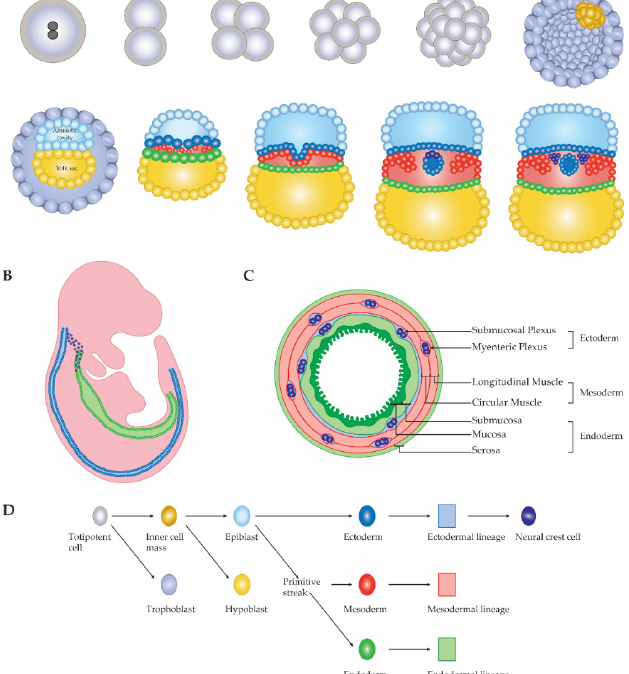
Figure 2. Schematic representation of early embryonic development. ( A ) First divisions and differentiations of the developing embryo, depicting the formation of the three germ layers and the neural crest cells. ( B ) The highly proliferative and migratory ectodermal neural crest, begins to enter the endodermal gut tube at week 4 of human gestation. Some of these cells will also contribute to the neural cells of the lungs and the pancreas. ( C ) Cross section of the colon to highlight contribution from all three germ layers, with the lowest contribution being from ectoderm/neural crest. ( D ) Legend of cell types and their origins.